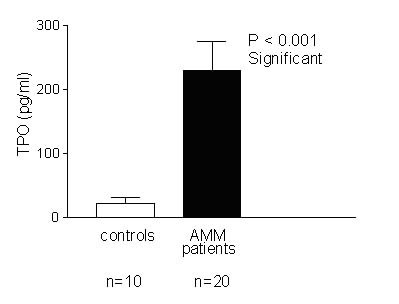
TPO is elevated in AMM patients. TPO level in the undiluted Platelet Poor Plasma samples of 10 controls and 20 AMM patients was tested by ELISA. While TPO level was in the range of 0–71 pg/ml in controls (Mean 22.8 pg/ml), it ranged between 0–684 pg/ml in AMM patients (Mean 229 pg/ml). This elevation of TPO level in patients was significant (P < 0.001) compared to controls.